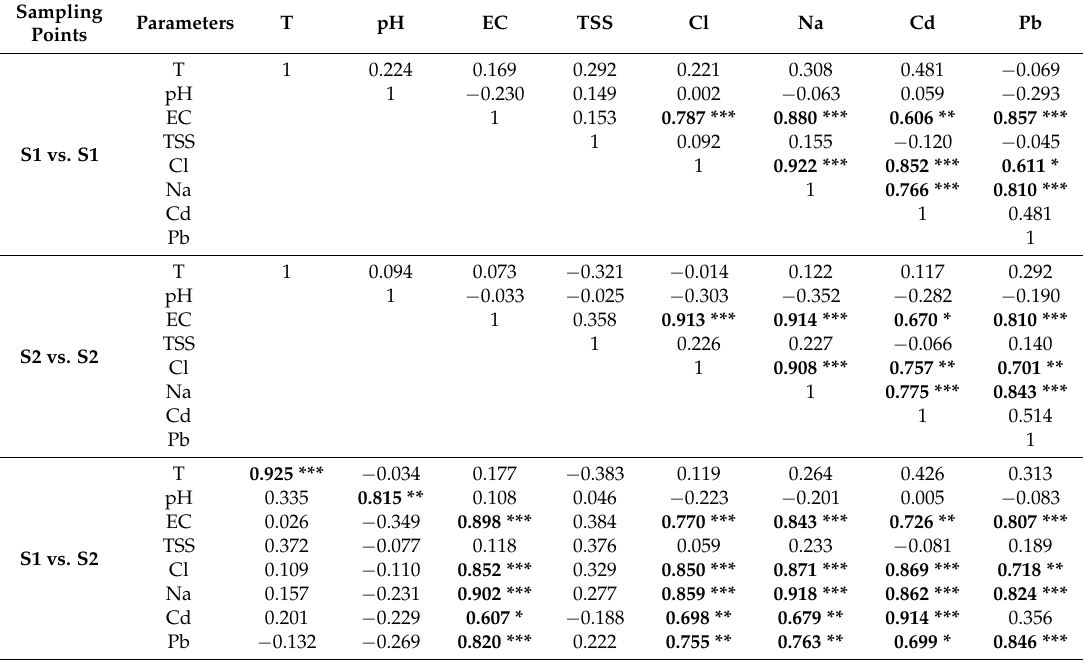
Pearson’s correlation coefficients among influent (S1) and effluent (S2) surface water